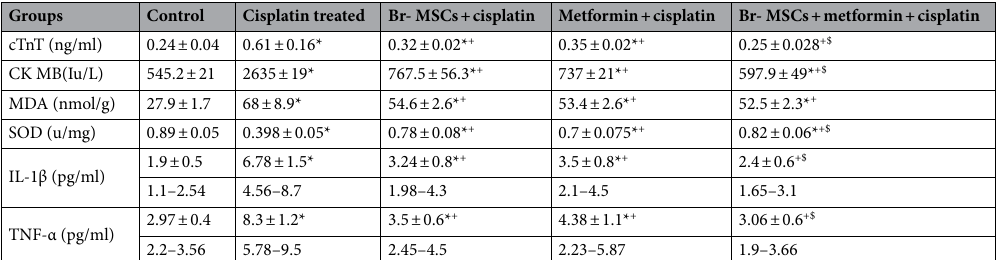
Table 2. Effect of Br-MSCs, metformin and their combination on the cardiac enzymes (cTnT and CK-MB), lipid peroxidation markers (MDA and SOD), and the pro-inflammatory cytokines (TNF-α and IL-1β) in adult male albino rats with cisplatin-induced cardiotoxicity. Statistical analysis was done by using one way ANOVA test. Values were expressed as (mean ± SD). Br‑MSCs Breast Milk mesenchymal stem cells, cTnT cardiac troponin, CK‑MB serum creatine kinase, MDA Malondialdehyde, SOD Superoxide dismutase enzyme, TNF‑α Tumor necrosis factor-alpha , IL‑1β Interleukin-1-β. *P < 0.05 when compared with control. + P < 0.05 when compared with cisplatin. $ P < 0.05 when compared with Br-MSCs + cisplatin.